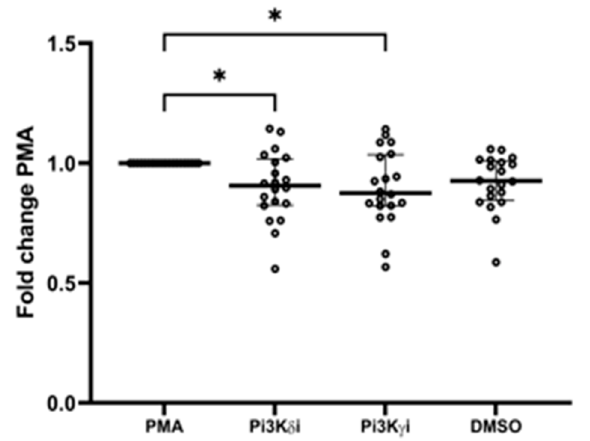
Figure 6. PI3K inhibition. COVID-19 neutrophils were pre-incubated for 30 min with PI3K σ inhibitor CAL101 and PI3K γ inhibitor AS252434, and NET release measured in response to PMA stimulation. Data shows fold change in absorbance of PMA stimulated neutrophils compared to PMA control, n = 18. * p = 0.0129 PMA vs. PI3K σ I, * p = 0.0156 PMA vs. PI3K γ